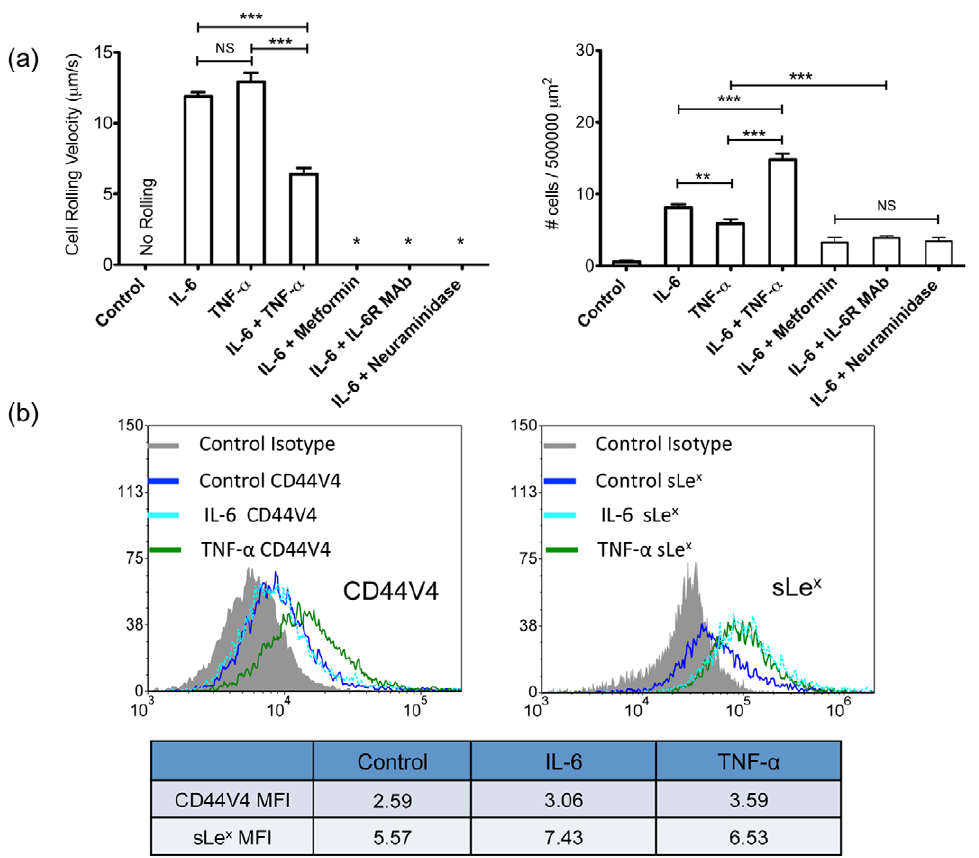
Figure 2. Pro-inflammatory cytokines IL-6 and TNF- a also induce adhesive recruitment of BCa cells and is blocked by the anti- inflammatory drug Metformin. (a) Average rolling velocity (left) and average number of MDA-MB-231 cells interacting with E-selectin coated surfaces (right) after treatments including 5 ng/mL of IL-6 (n=71), 5 ng/mL TNF- a (n=48), IL-6 + TNF- a (5 ng/mL each), 5 ng/mL of IL-6 with 0.1 mmol Metformin, 5 ng/mL of IL-6 with 1 m g/mL anti-IL-6R MAb, 5 ng/mL of IL-6 with neuraminidase treatment prior to rolling experiment. For conditions where MDA-MB-231 were treated with IL-6 with MAb, Metformin, or neuraminidase (after IL-6 treatment), there were insufficient numbers of cells found on the E-selectin coated surface for velocity analysis. Bars represent mean 6 SEM. P , 0.0001, two-tailed unpaired student t-test. Average number of MDA-MB-231 cells from control experiment was found to be significantly less than all other conditions (P , 0.0001). (b) Flow cytometry measurements of CD44V4 (left) and sLe x (right) expression on untreated, IL-6 (5 ng/mL), and TNF- a (5 ng/mL) treated MDA-MB-231 cell surfaces. Mean fluorescence intensity ratio of sample over isotype has been included.